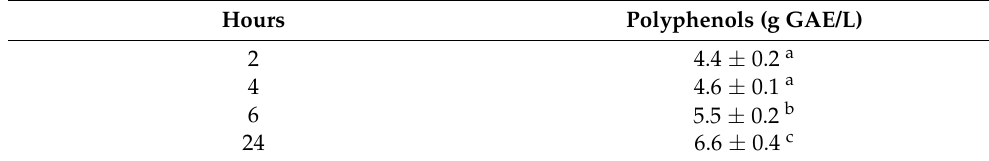
Table 1. Total phenolic content in DOLE at different times of extraction.